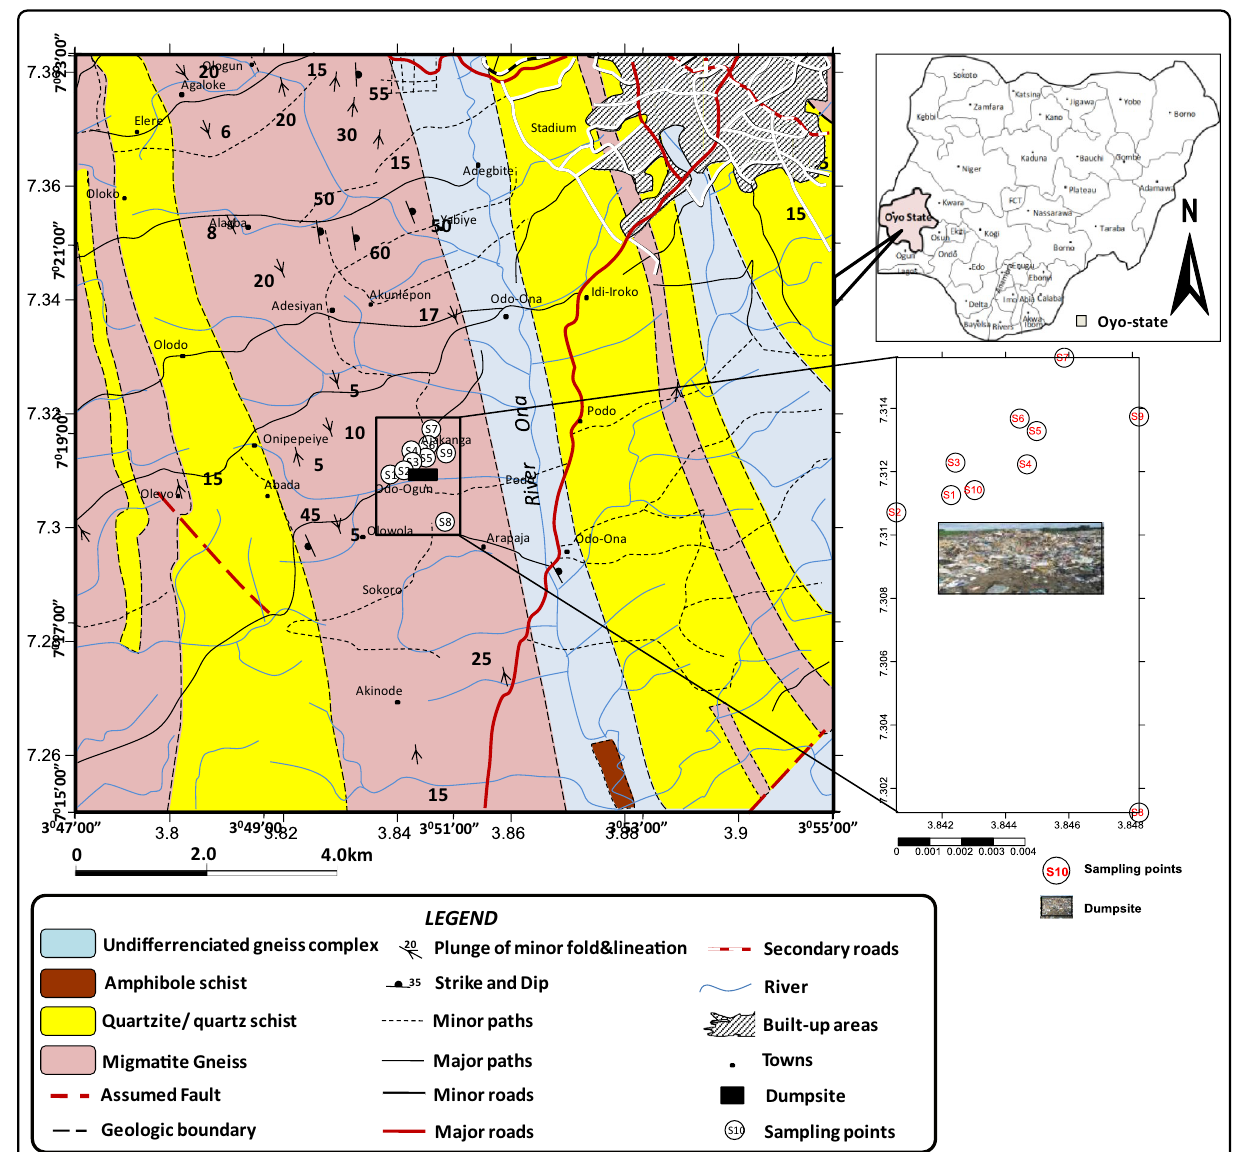
Fig. 4 Geological map showing the rock type that underlies the sampled area, dumpsite and layout of the sampling points (reproduced with per- mission from Jones and Hockey